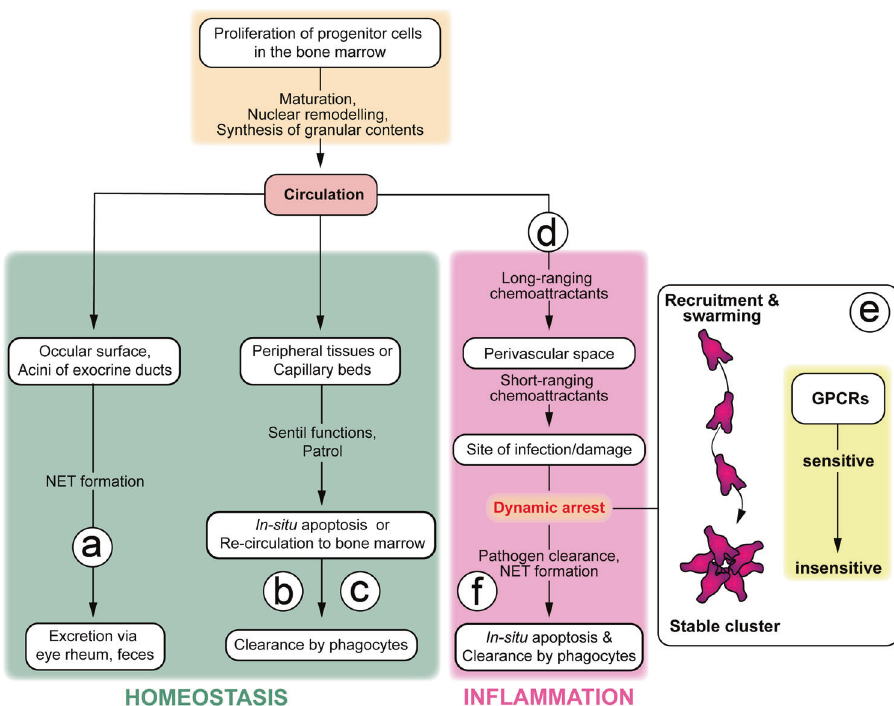
Fig. 1 Neutrophil fates under homeostatic or in fl ammatory conditions. Neutrophils arise from precursor cells in the bone marrow and are released into the bloodstream, from where they set out to patrol the internal tissues as well as the ocular surfaces and exocrine ducts. Under homeostatic conditions (green box), neutrophils undergo different fates: (a) NET formation and excretion, (b) in situ apoptosis or (c) re- circulation to the bone marrow and clearance. Under in fl ammatory conditions (red box), neutrophils are attracted to the site of infection or damage (d) fi rst through a sequential combination of long- and short-ranging chemoattractants. The latter mediates the coordinated extravascular aggregation dynamics known as swarming behavior. Kienle et al. 1 now show that preprogrammed desensitization of the very G-protein-coupled receptors (GPCRs) that drive swarming is an intrinsic feedback control that leads to dynamic arrest (e). This arrest ensures stable cluster formation and is critical for their antibacterial effector functions. Successful elimination of the invading pathogen is then followed by apoptosis in situ and elimination by recruited phagocytes (f), which is the trigger for the active resolution of in fl